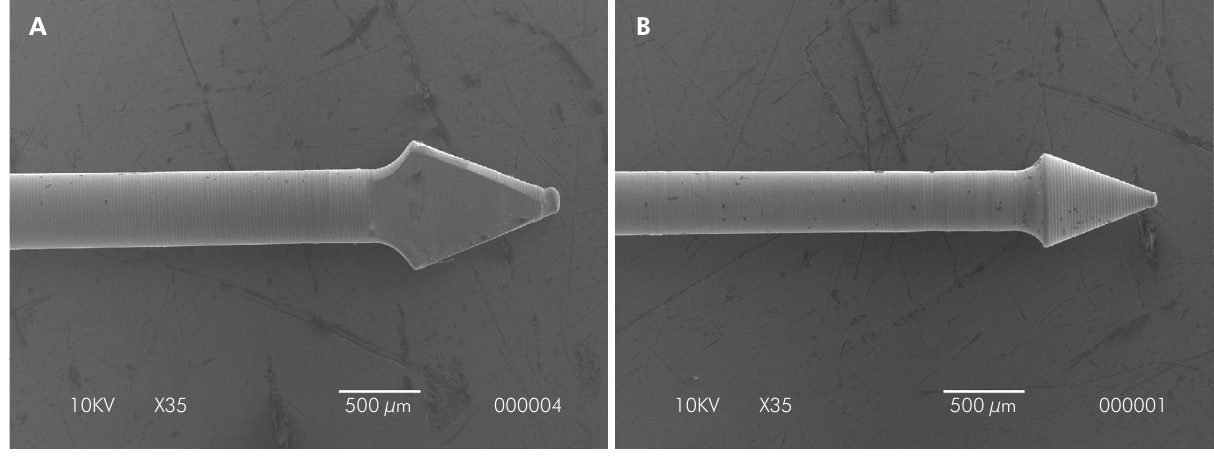
Figure 1. (A) Scanning electron microscopy (SEM) image of the Flatsonic tip (original magnification, 35x); (B) Scanning electron microscopy (SEM) image of the Clearsonic tip (original magnification,